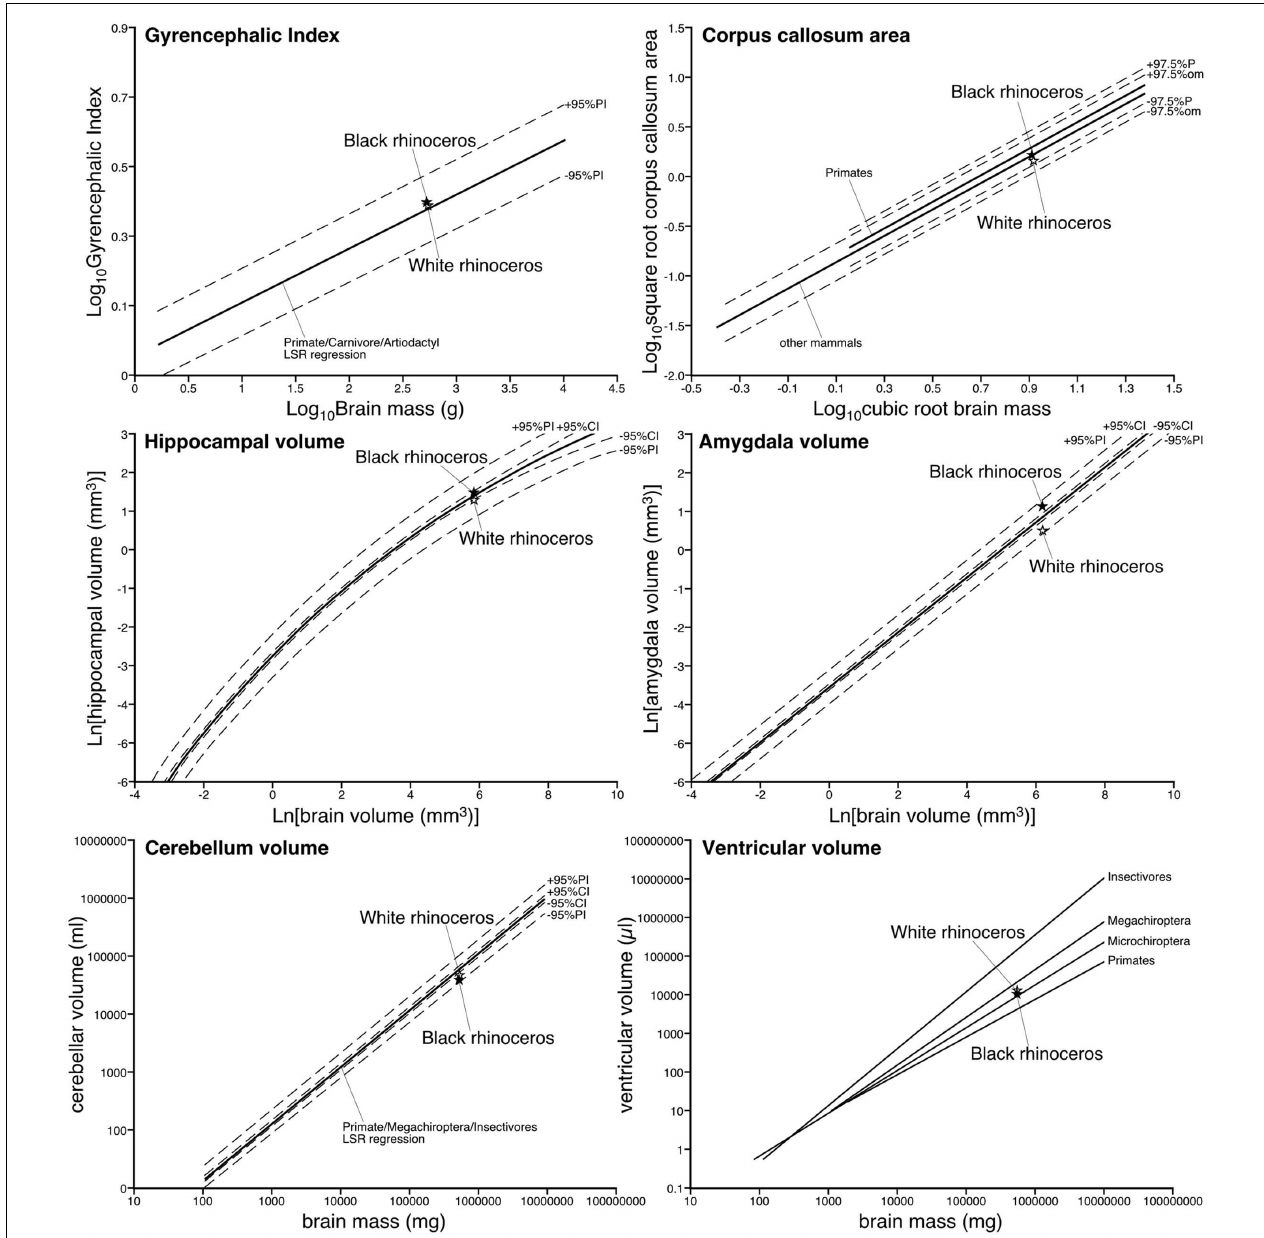
FIGURE 7 | Graphs depicting the relative size of various parameters of the central nervous system in the black and white rhinoceroses in comparison to regressions derived on data from other mammals previously reported. Note that for all parameters measured the relative size of these parameters are close to what would be predicted based on the data from other mammals. Thus, the relative proportions of the brain of the rhinoceroses appear to be typically